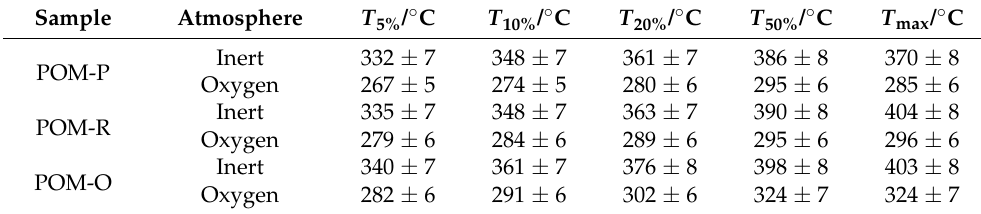
Figure 5. TG thermograms for POM-O sample: red line—investigations carried out in oxygen atmosphere; blue line—investigations carried out in the inert atmosphere, at a heating rate of 10 ◦ C/min. Table 4. The most important thermogravimetric indicators in the